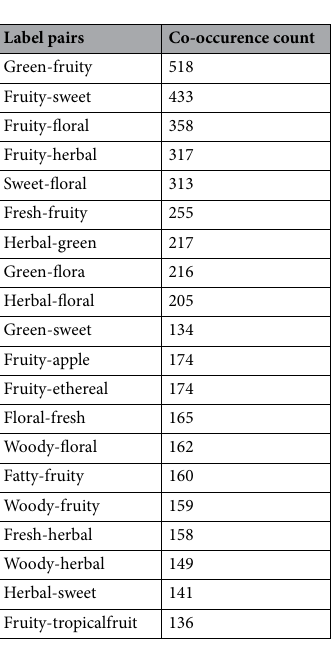
Table 2. Top 20 odor associations labels. The darker the intensity of a square, the lesser the magnitude of co-occurrence count and correlation between the two labels.